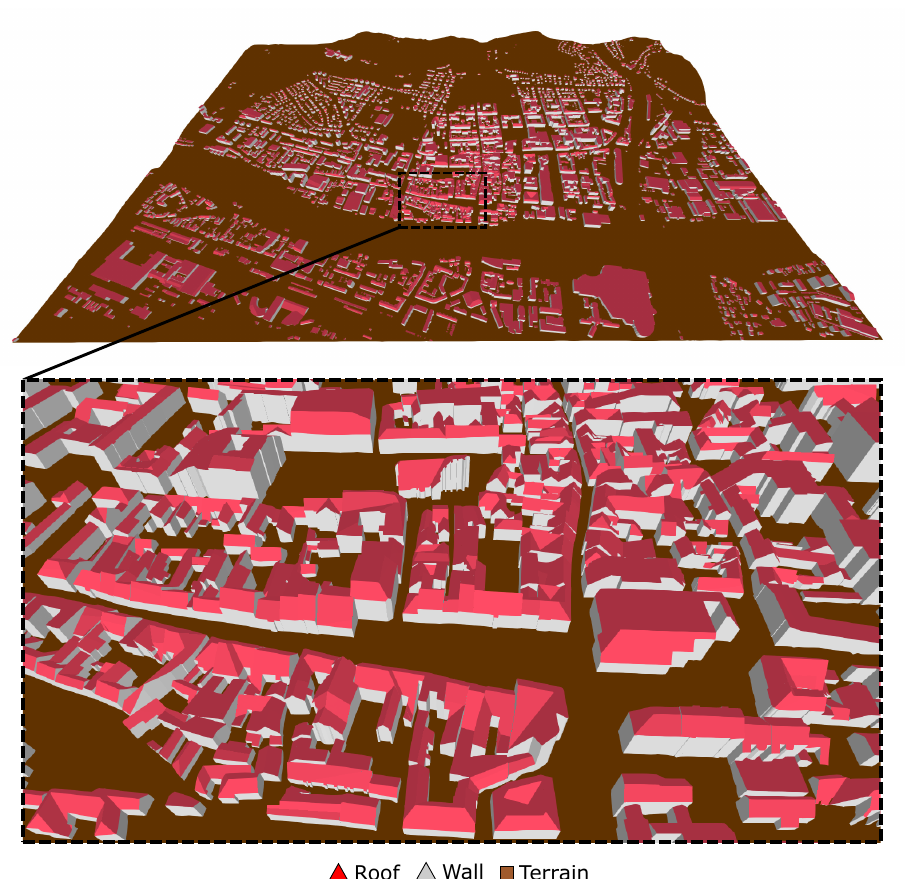
Figure 9. Reconstructed building models for the input point cloud from Figure